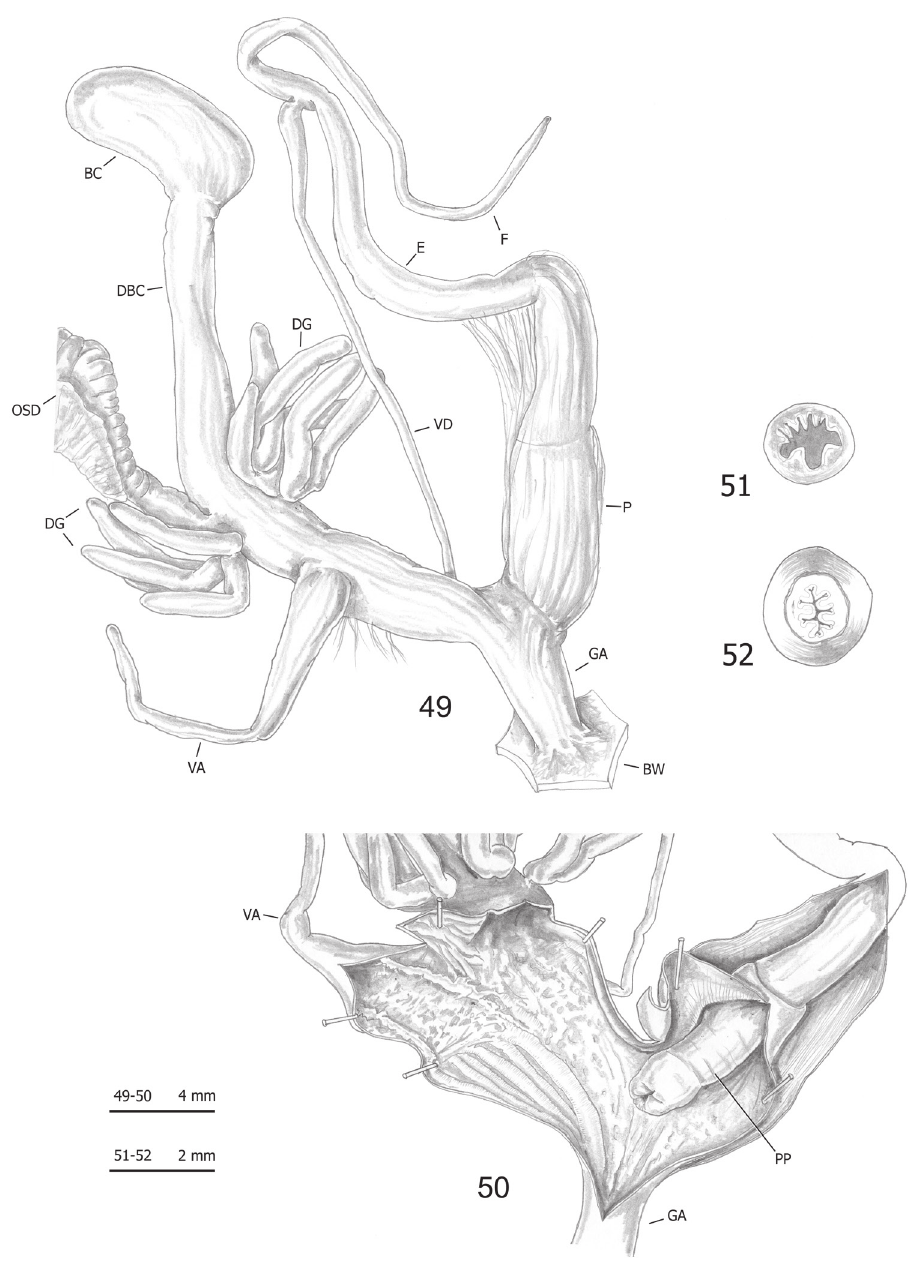
Figures 49–52. Genitalia (proximal parts excluded) ( 49 ), internal structure of distal genitalia ( 50 ), transverse sections of medial epiphallus ( 51 ) and apical penial papilla ( 52 ) of Monacha pantanellii from Valle dell’Aniene, Roccagiovine [Ani] (FGC